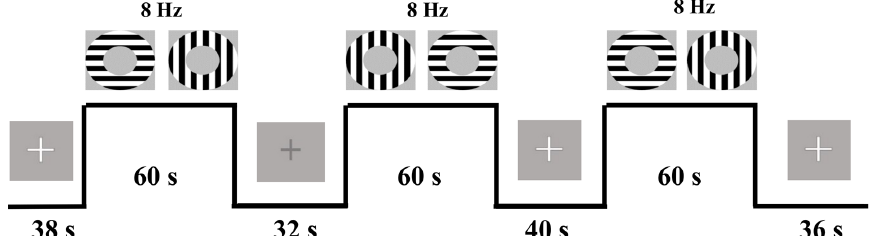
Figure 1. Example of three-trial visual stimulation task. Participants viewed a fixation cross at the center of the screen. This cross changed color at jittered intervals throughout task. Rest periods were also jittered. Continuous stimulation blocks lasted 60 s with 0° to 90° flickering annuli (at 8 Hz). Note: fixation cross was presented during task and rest periods however it cannot be seen in the task example periods here.